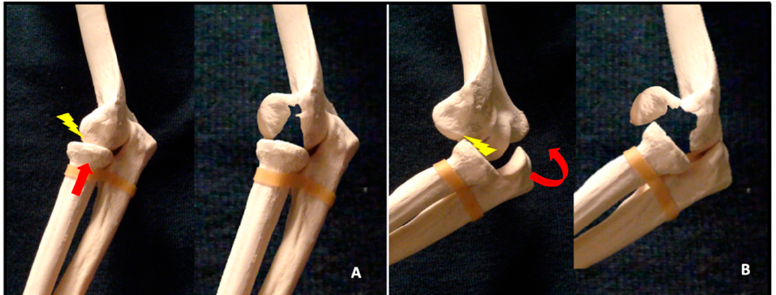
Figure 1. Pathogenic mechanisms of coronal shear fractures. The fracture is a result of: ( A ) an impact along the radius in full extension; or ( B ) posterolateral dislocation, often with posterior capitellar impaction; the radial head shears off the capitellum during the relocation of the elbow. The red arrow represents the direction of the force of the trauma. The yellow bolt points the site where the force is applied on the distal